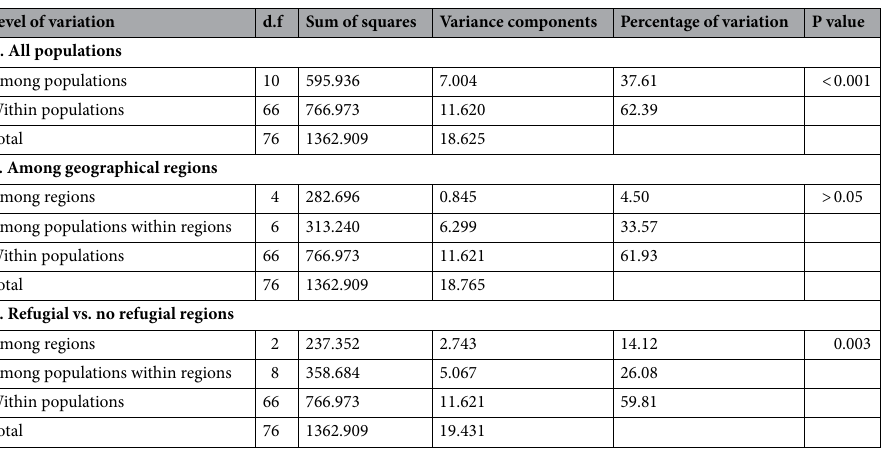
Table 4. Analysis of molecular variance (AMOVA) of Gladiolus imbricatus in the Polish Carpathians. A—with no geographical structuring; B—with 5 geographical regions; C—with 2 refugial (Pieniny and Tatra Mts) vs. 3 no refugial regions (Gorce, Beskid Niski, Bieszczady